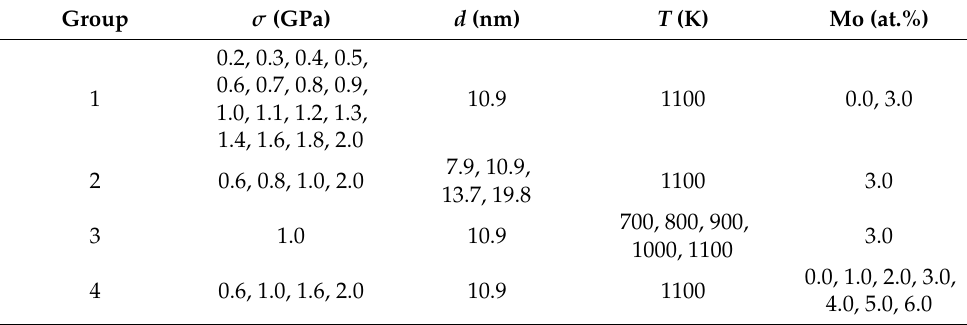
Table 1. Parameters in the creep simulation of NC Ni-Mo alloy.